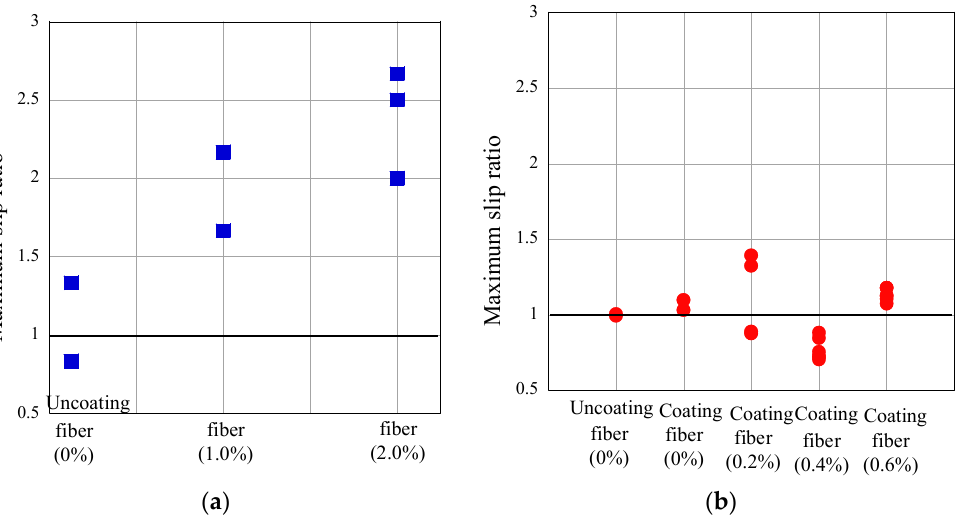
Figure 10. Comparison of the maximum slip ratios at peak load: ( a ) uncoated rebars [32];( b ) UHPC-coated rebars.